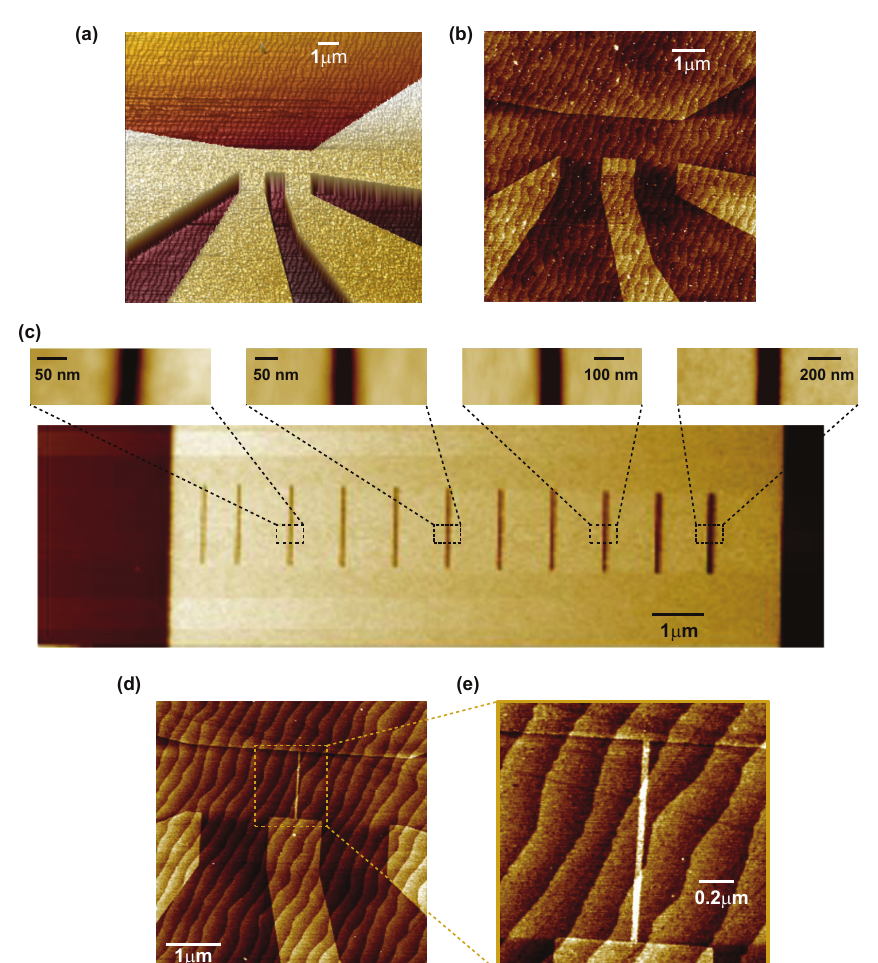
Figure 3. ( a ) AFM topography 3D image of the negative resist template after first electron beam lithography. Resist thickness is 60 nm. ( b ) AFM topography image of the same structure after ion beam irradiation and resist removal. ( c ) AFM topography image of open slits with a width ranging between 20 and 140 nm which were fabricated in positive e-beam resist after dose optimization in the second electron beam lithography. ( d ) AFM image of the final device containing a weak link with barrier thickness 30 nm. ( e ) Enlarged region of the AFM image shown in ( d ) containing weak link structure. Darker regions correspond to conducting paths, whereas light regions are highly resistive and insulating